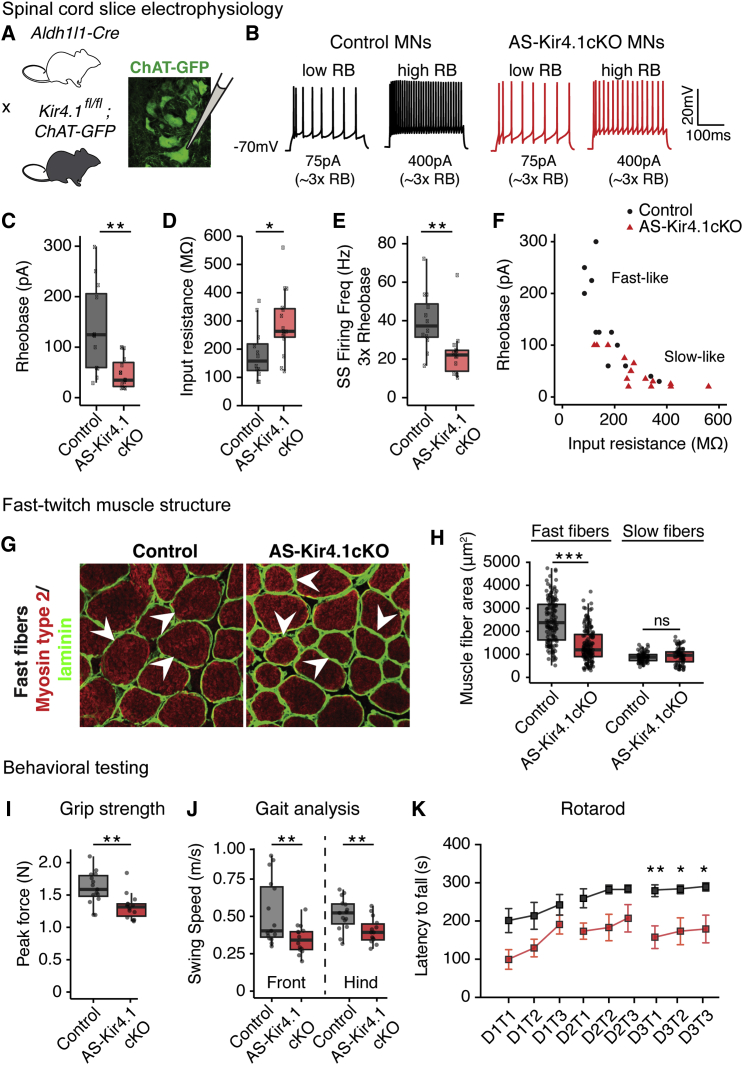
AS Kir4.1 Is Required for FαMN Function, Fast-Twitch Muscle Fiber Size, and Peak Force(A) Breeding scheme and electrophysiology recording schematic.(B) Two representative current steps at 3× rheobase (RB).(C–E) Rheobase (C), input resistance (D), and steady-state (SS) firing frequency (at 3× rheobase) (E) demonstrate altered intrinsic electrophysiological deficits in MNs from AS-Kir4.1cKO-ChAT-GFP animals at P12–P15 (n = 12 control MNs, n = 14 AS-Kir4.1cKO MNs from at least 3 animals per group, boxplot, Mann-Whitney test).(F) Input resistance versus rheobase scatterplot shows shift in electrophysiological properties from fast-like to slow-like in AS-Kir4.1cKO compared to control MNs.(G) Cross sections of TA muscle fibers immunolabeled for marker of fast-twitch muscle (myosin type 2) and laminin in P30 AS-Kir4.1cKO and cre-negative control animals (scale bar, 50 μm).(H) Quantification of TA muscle fiber cross-sectional area (n = 3 mice/group, >100 muscle fibers/animal, boxplot, Mann-Whitney test).(I–K) Abnormal muscle strength behavior in AS-Kir4.1cKO mice. Adult AS-Kir4.1cKO animals generate less peak force (>P50, n = 14–15 mice/group, boxplot, Welch’s t test) (I). AS-Kir4.1cKO animals have slower front and hindlimb movements as assessed by gait analysis with the catwalk behavioral test. Swing speed corresponds to the limb speed while in the air (same animals as in I, boxplot, Welch’s t test) (J). AS-Kir4.1cKO animals display a shorter latency to fall on the accelerating rotarod at P30–P35 (n ≥ 7 mice/group, mean ± SEM, two-way ANOVA, Bonferroni post hoc test) (K). Mice performed three trials (T, T2, and T3) per day on 3 consecutive days (D1, D2, and D3). ∗p < 0.05, ∗∗p < 0.01. Edges of boxplots denote interquartile range (25th–75th percentile) with whiskers denoting 1.5 times the interquartile range and black line denoting the median value.